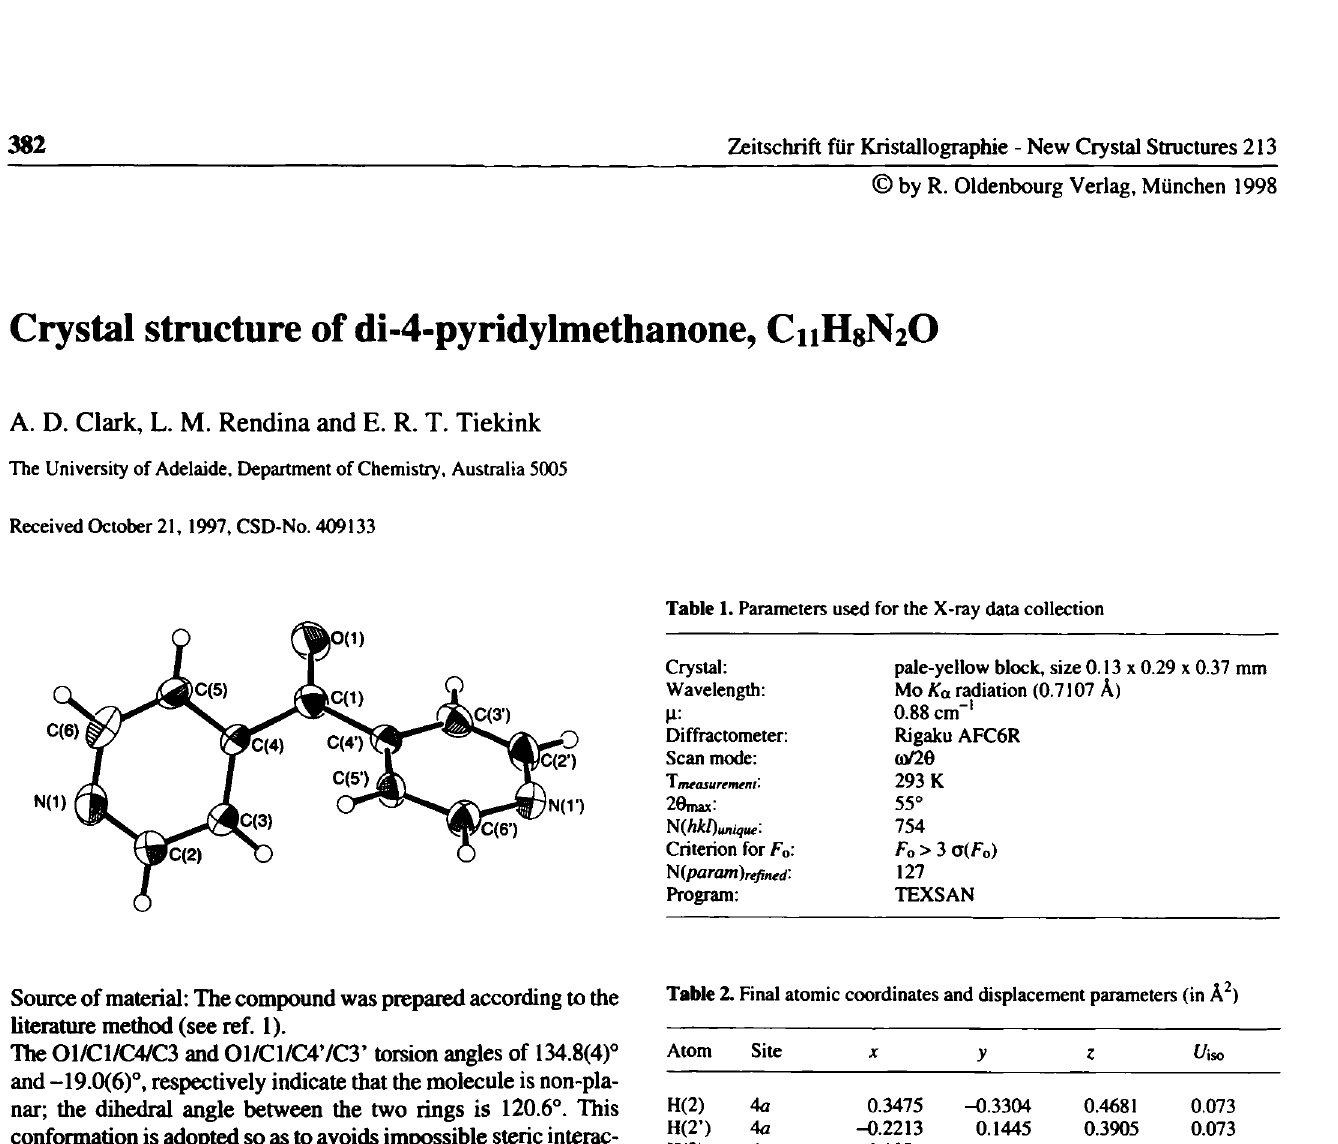
Table 3. Final atomic coordinates and displacement parameters (in Â^)